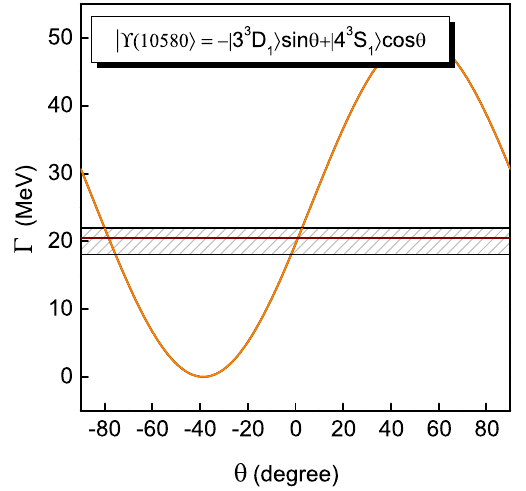
Fig. 4 Strong decay of ϒ( 10580 ) versus the mixing angle θ within screened potential model.The horizontal line is the center value of the experiment, and the shaded region represents the error range of the